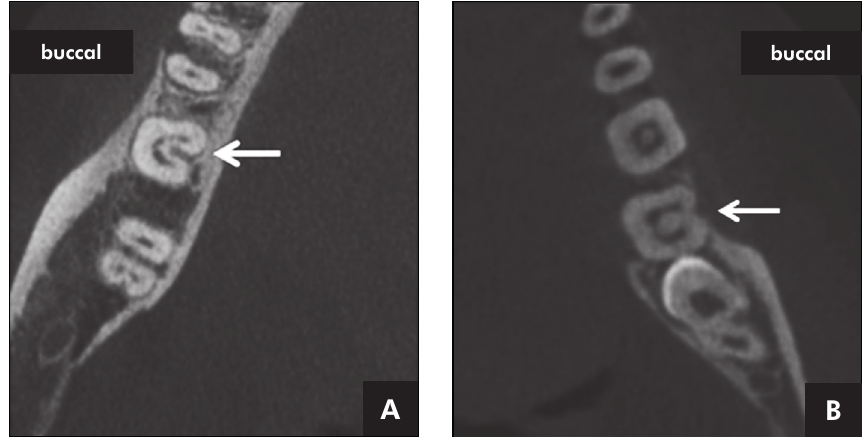
Figure 2 - Examples of C-shaped groove directions. A: a case with a groove in the lingual